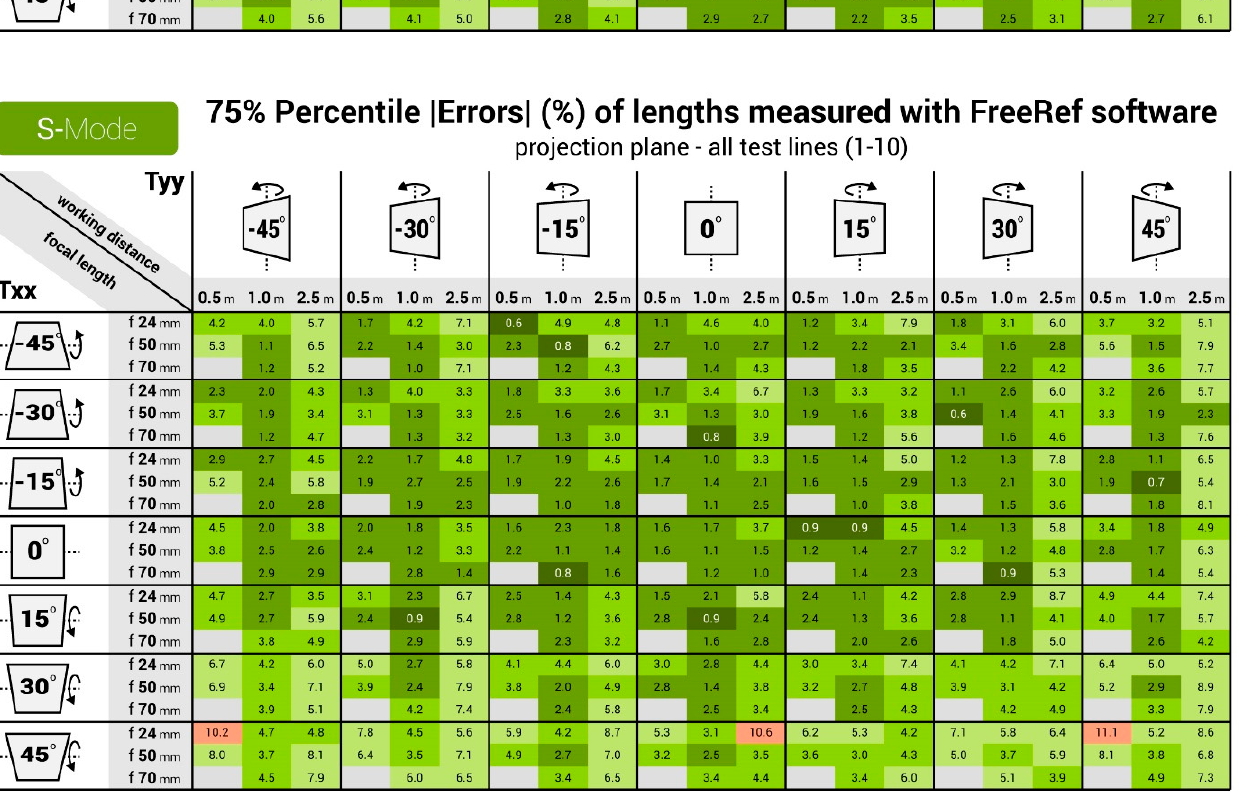
Figure 10. Heat maps for the S-mode verification measurements, showing the ( Top ) median and ( Bottom ) 75 percentile values of absolute percentage measurement errors for all tested focal lengths, working distances and calibration plate rotations Txx and Tyy.